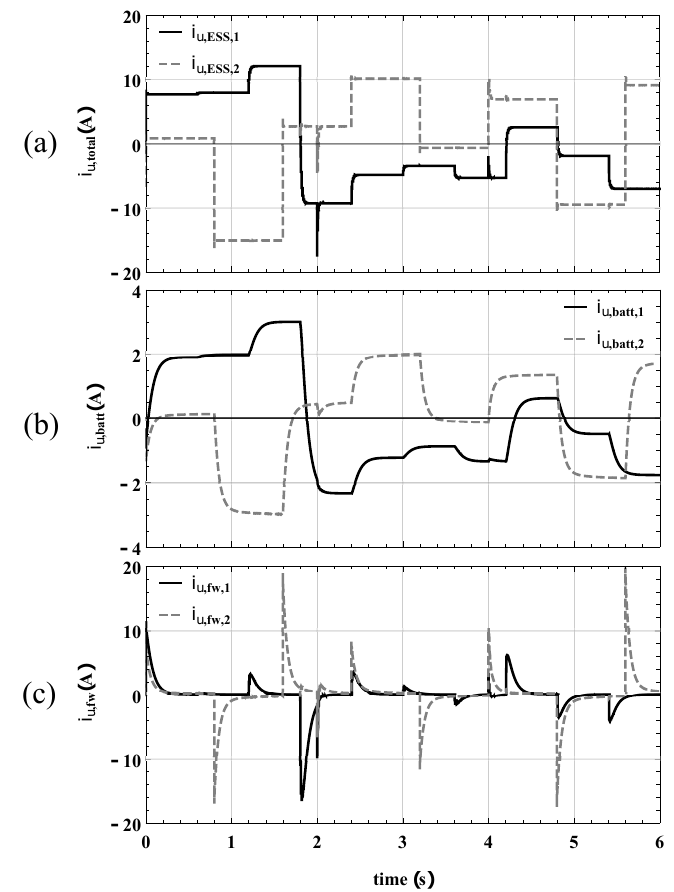
Figure 18. ESS 1 and ESS 2 ( a ) overall, ( b ) individual battery, and ( c ) flywheel current